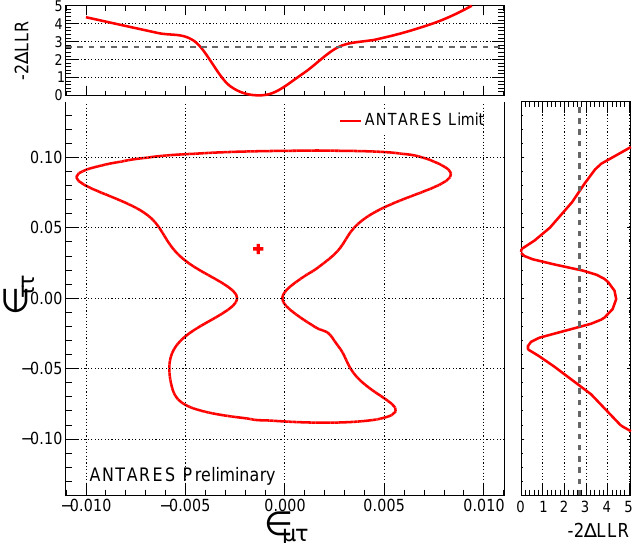
Figure 8. Contours of 90% confidence level on the ε µτ ε ττ plane, after 10 years of ANTARES data. − The cross indicates the best-fit point. The top and right lateral plots show the 1D profile likelihood of the respective NSI parameter when the other parameter is fitted over. The dashed straight lines indicate the 90% CL value for one degree of freedom. Credit: ANTARES